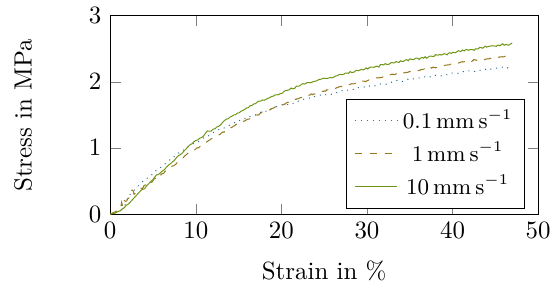
Figure 3. Stress-strain diagram for 0 . 1 mm s − 1 , 1 mm s − 1 and 10 mm s − 1 .